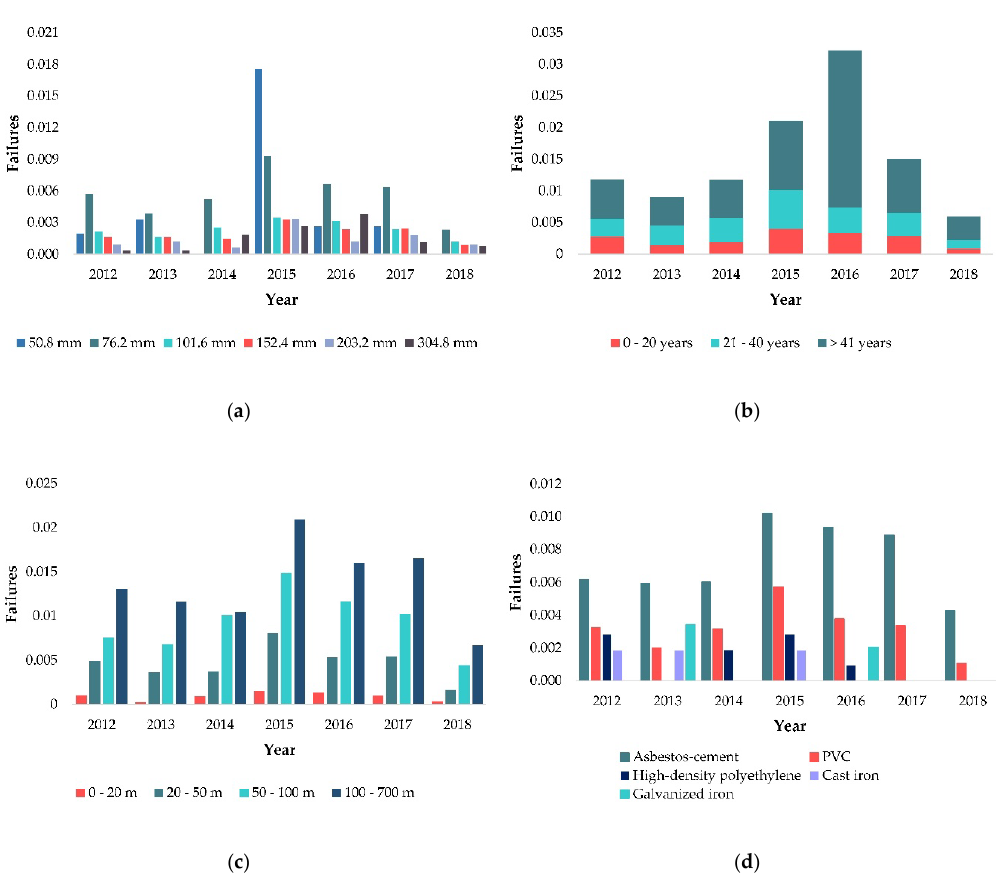
Figure 3. Relationship between: ( a ) Pipe diameter and failures normalized by the number of pipes of each diameter; ( b ) Pipe age and failures normalized by the number of pipes of each age range; ( c ) Pipe length and failures normalized by the number of pipes of each length range; ( d ) Pipe material and failures normalized by the total of pipes of each material.